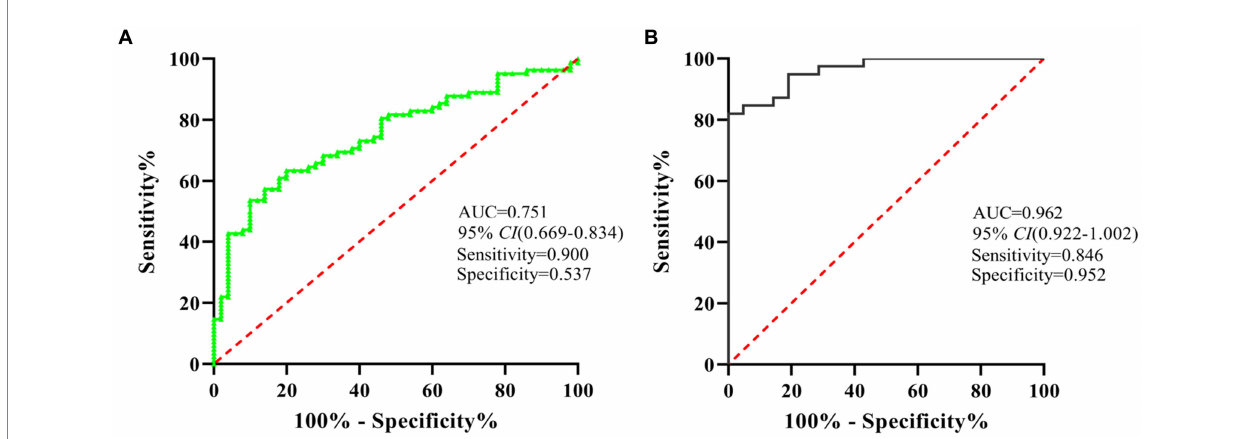
FIGURE 4 ROC analysis showed that miR-320 had a decent diagnostic performance for the identification of MA use disorder patients. (A) ROC curve analysis of miR-320 in plasma. (B) ROC curve analysis of miR-320 in exosomes. CI, confidence interval.